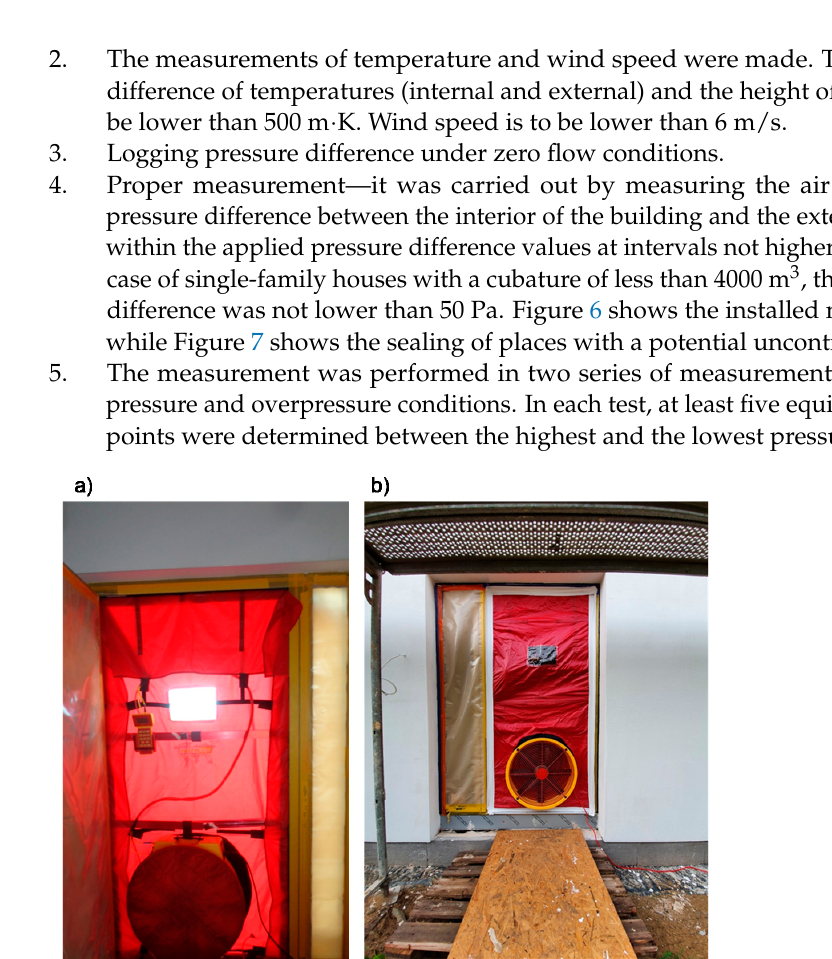
Figure 5. Visualization of the object during the measurement.